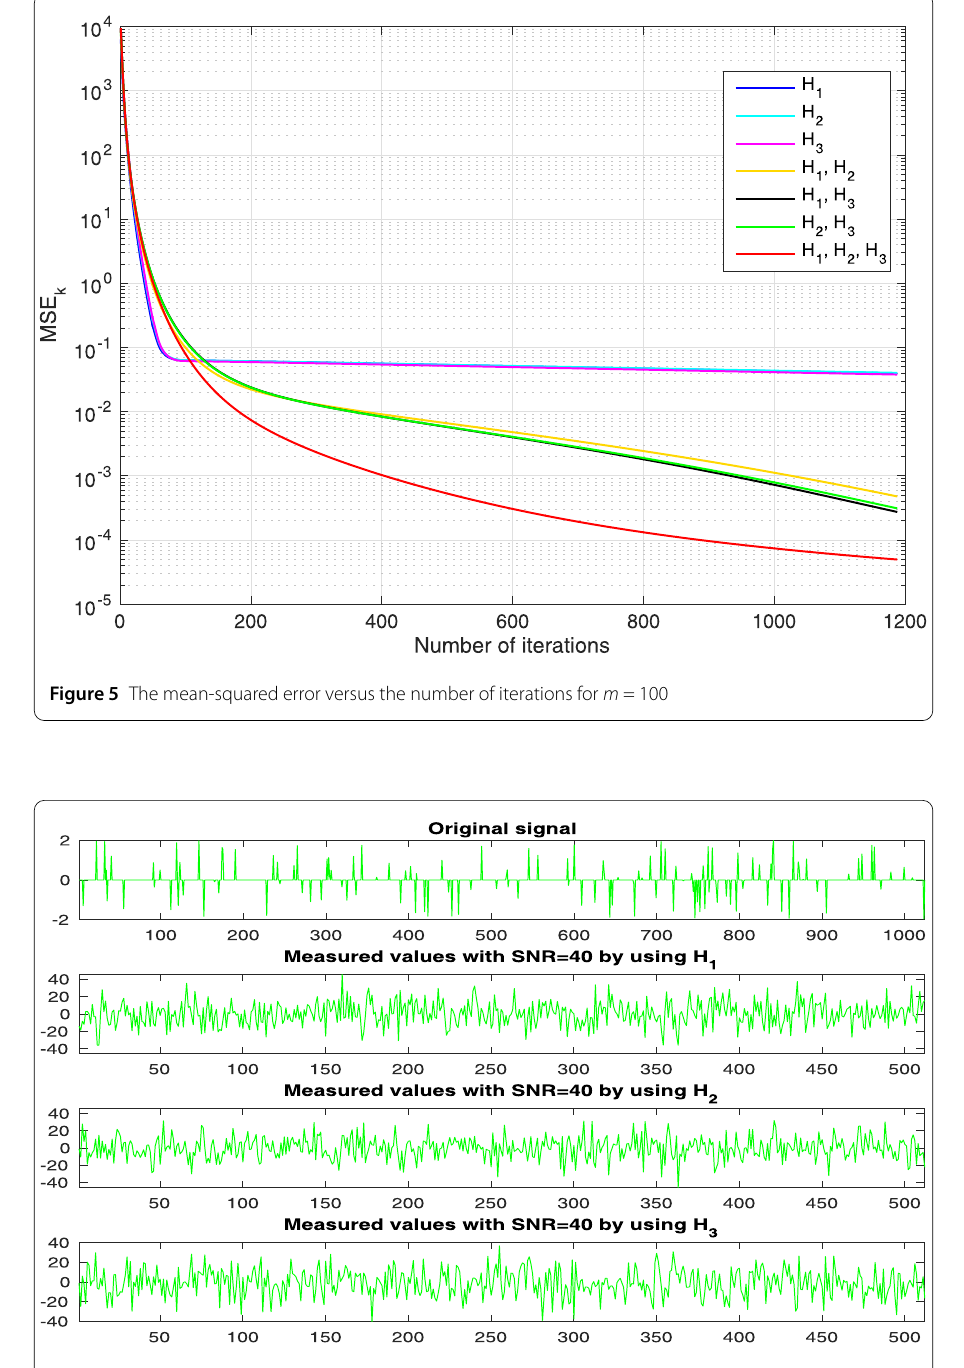
is generated by white Gaussian noise with signal-to-noise ratio SNR=40, η i = 1, λ i = 0.95, and γ i = 0.01 for all i = 1,2,3. Select a k = 1 1 as in Case 6 for all k ∈ N . Further, for any k ∈ N and all i = 1,2,3, we select α i